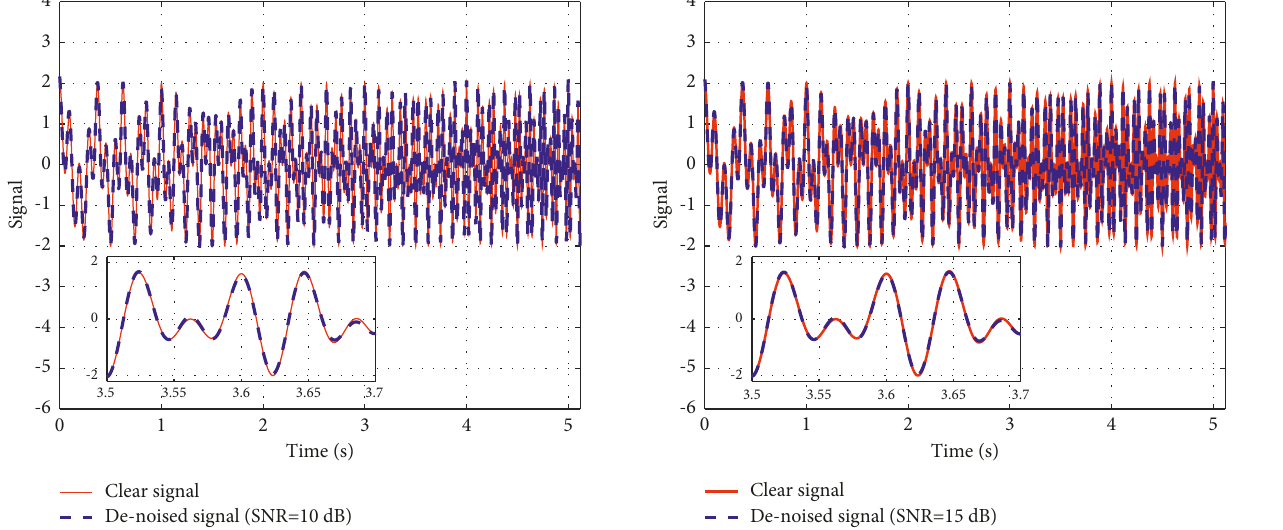
Figure 4: Noise elimination of non-stationary signal using pro- posed method when SNR � 10dB.